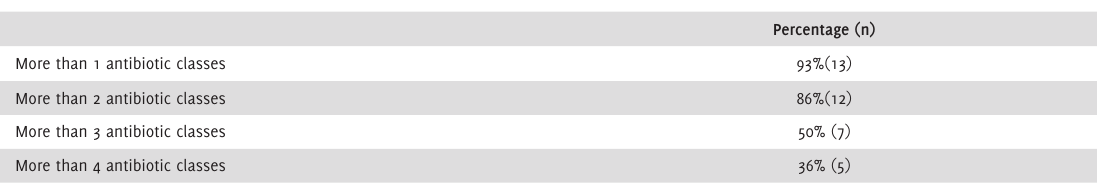
Table 2. Resistance profile of Staphylococcus aureus